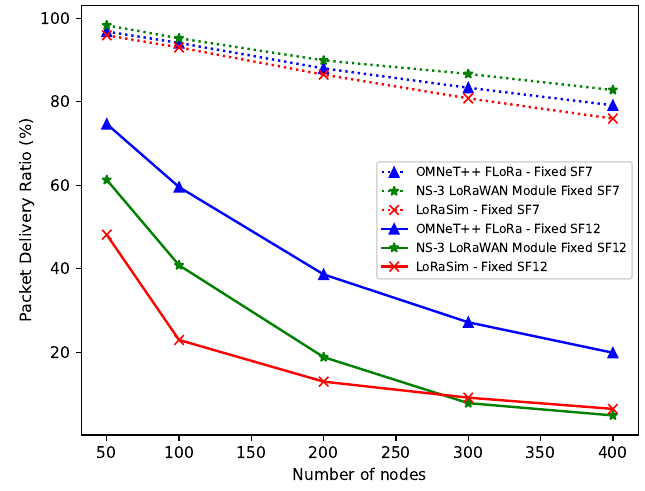
Figure 8. PDR vs. number of nodes.